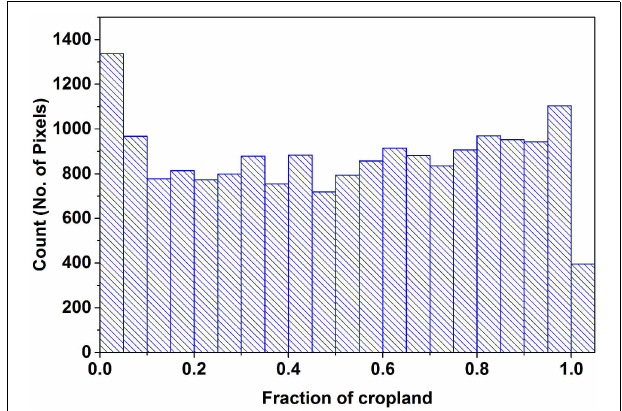
FIGURE 4 | Histogram of cropland fraction in MODIS 500m pixels derived from the MOD09A1 product over Jagatsinghpur and Kendrapara districts in Odisha, India. The cropland fraction within a MODIS 500m pixel was derived from Landsat 30m cropland map from the 2009 kharif rice growing